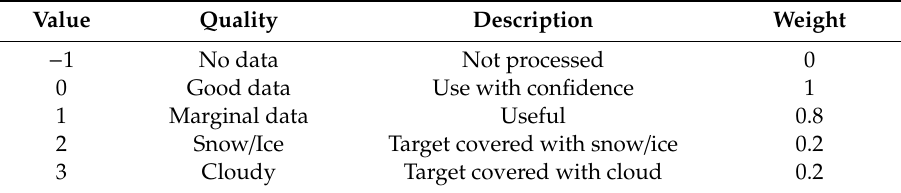
Table 1. Descriptions of “data pixel reliability” in MOD13A2 and weight.